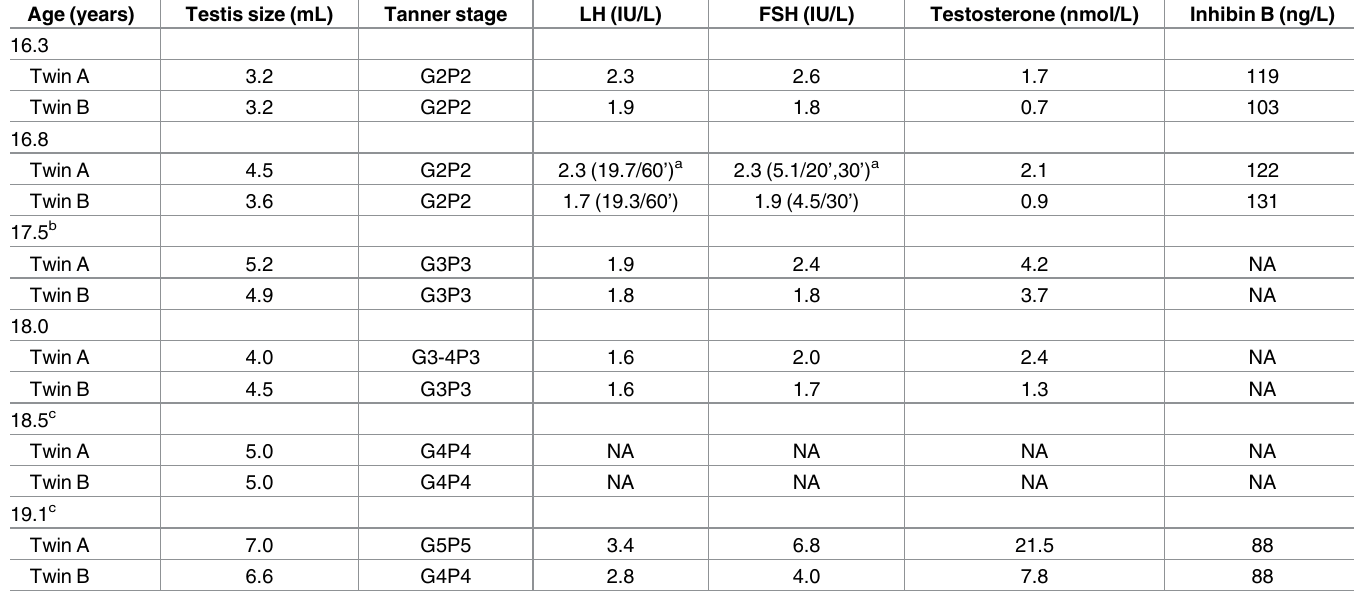
Table 2. Clinical and hormonal findings in two monozygotic twin brothers who presented with stalled puberty due to compound heterozygous mutations in the GNRHR gene (c.317A > Gp.(Gln106Arg) and c.785G > Ap.(Arg262Gln)). Age